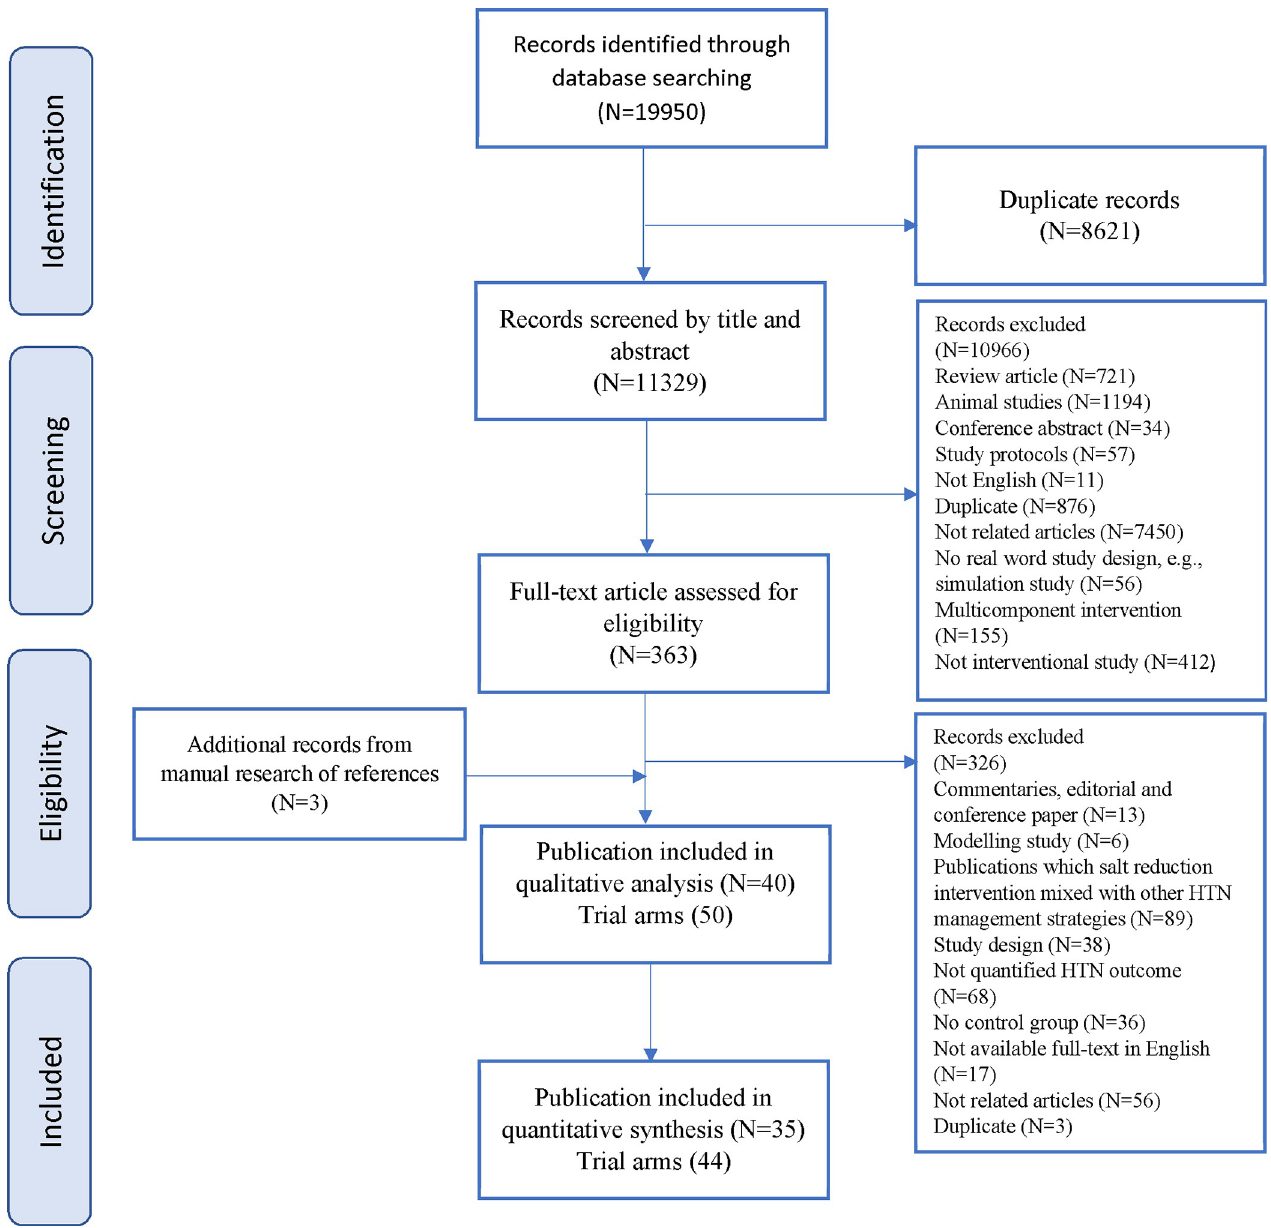
Fig 1. Flow diagram of the study screening and selection